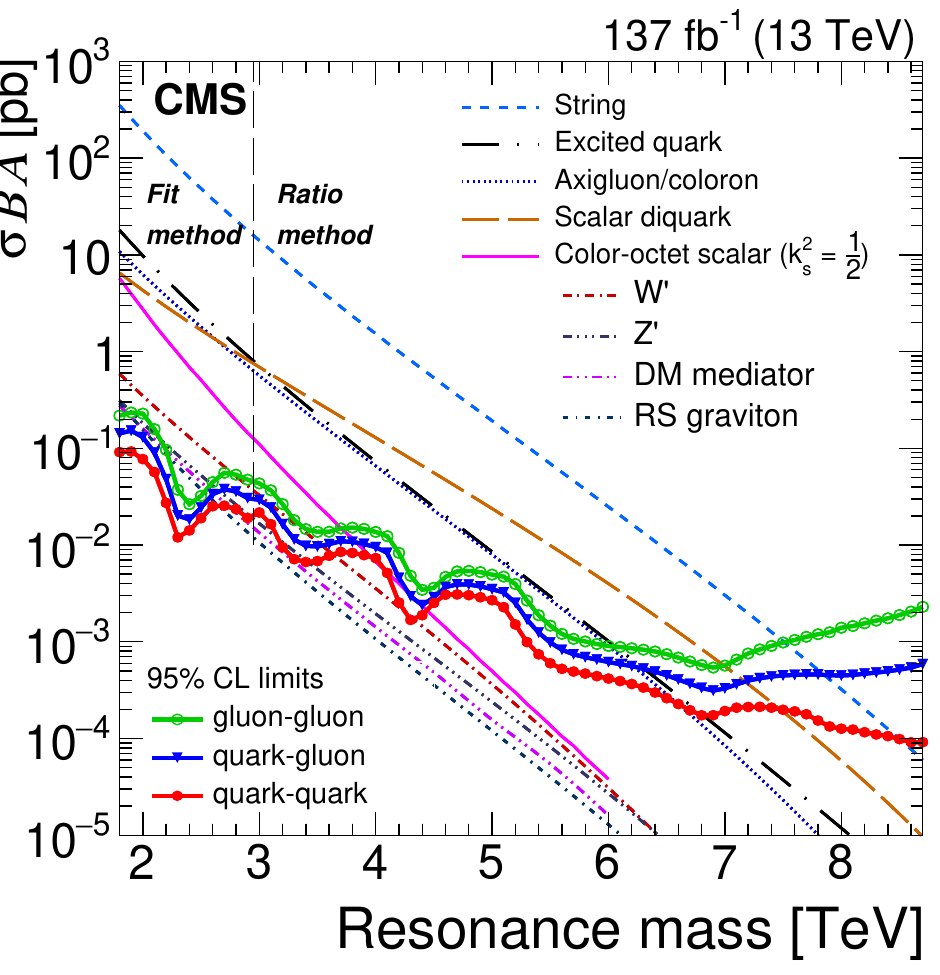
Figure 7 . The observed 95% CL upper limits on the product of the cross section, branching fraction, and acceptance for quark-quark, quark-gluon, and gluon-gluon type dijet resonances. Limits are compared to predicted cross sections for string resonances [1, 2], excited quarks [4, 5], axigluons [6], colorons [8], scalar diquarks [3], color-octet scalars [9], new gauge bosons W 0 and Z 0 with SM-like couplings [10], DM mediators for m = 1 GeV [14, 15], and RS gravitons [11]. The vertical dashed DM line indicates the boundary between the regions where the (cid:12)t method and the ratio method are used to estimate the background.